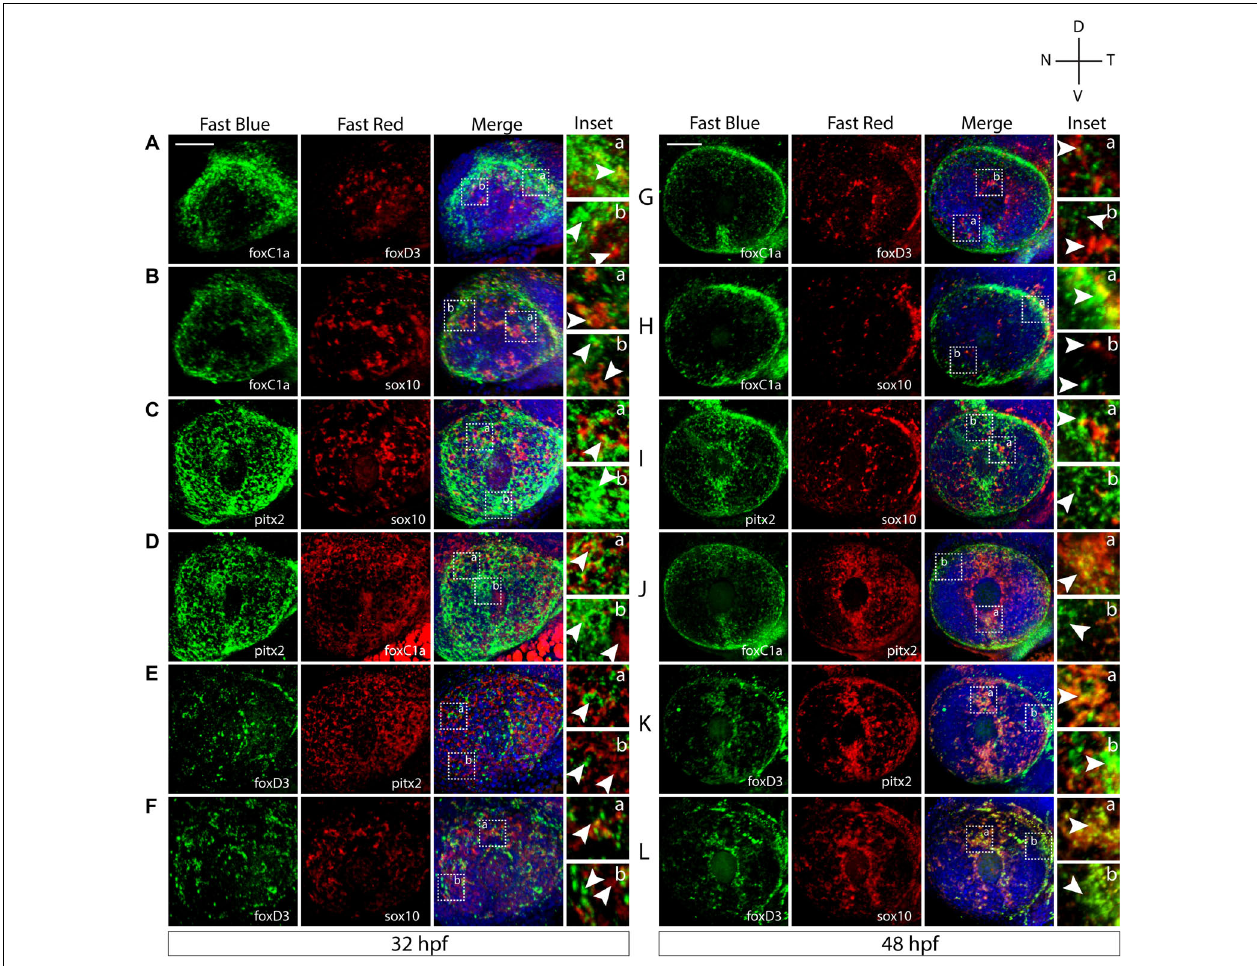
FIGURE 2 | Two-color fluorescent in situ hybridization supports ASM heterogeneity. Two-color fluorescent WISH (FWISH) performed for all possible combinations of foxc1a , foxd3 , pitx2 , and sox10 at 32 (A–F) and 48 hpf (G–L). DAPI is in blue. Lateral images of 3D reconstructions are displayed. White arrows within inset panels (dashed squares) display instances of individual (b) and co-expression (a) . Scale bar = 50 µ m.